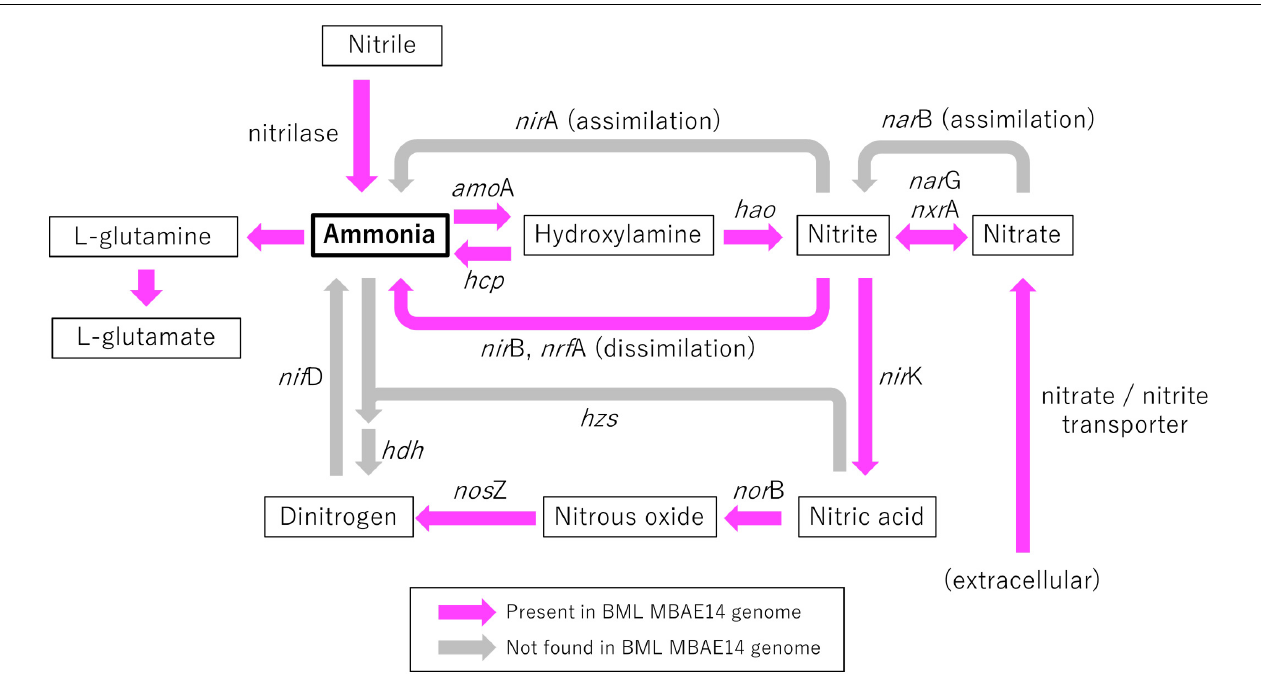
FIGURE 6 | Schematic model of functional genes involved in nitrogen metabolism encoded in the genome of BML MBAE14. Arrows indicate functional gene pathways, which are present (pink) or absent (i.e., inferred; gray) in the genome. amo A, ammonia monooxygenase (EC 1.14.99.39); hcp , hydroxylamine reductase (EC 1.7.99.1); hao , hydroxylamine oxidoreductase (EC 1.7.2.6); nir A, (assimilatory) nitrite reductase (EC 1.7.7.1); nir B/ nrf A, (dissimilatory) nitrite reductase (EC1.7.1.15, 1.7.2.2); nar G/ nxr A, (dissimilatory) nitrate reductase/nitrite oxidoreductase (EC 1.7.5.1, 1.7.99.-); nar B, (assimilatory) nitrate reductase (EC 1.7.7.2); nir K, (NO-forming) nitrite reductase (EC 1.7.2.1); nor B, nitric oxide reductase (EC 1.7.2.5); nos Z, nitrous oxide reductase (EC 1.7.2.4); hzs , hydrazine synthase (EC 1.7.2.7); hdh , hydrazine dehydrogenase (EC 1.7.2.8); nif D, nitrogenase (EC